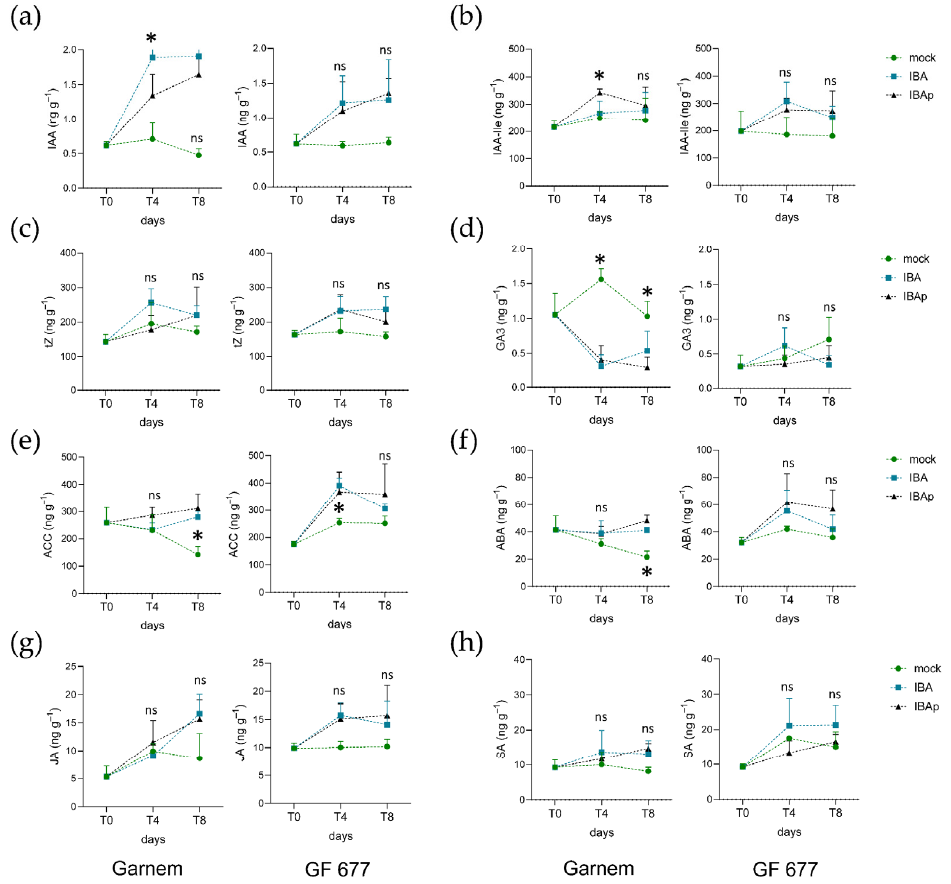
Figure 5. Hormonal profile of Garnem and GF 677 microcuttings during IBA-induced rooting. Endogenous levels of ( a ) indole-3-acetic acid (IAA), ( b ) IAA-Isoleucine (IAA-Ile), ( c ) trans-zeatin ( t Z), ( d ) gibberellic acid 3 (GA3), ( e ) 1-aminocyclopropane 1-carboxylic acid (ACC), ( f ) abscisic acid (ABA), ( g ) jasmonic acid (JA), and ( h ) salicylic acid (SA) measured in the basal region of Garnem (left panels) and GF 677 (right panels) microcuttings at 0, 4, and 8 dae. Asterisks indicate statistically significant differences ( p -value < 0.01) between treatments at the same time point, ns = no statistically significant differences ( p -value < 0.01).